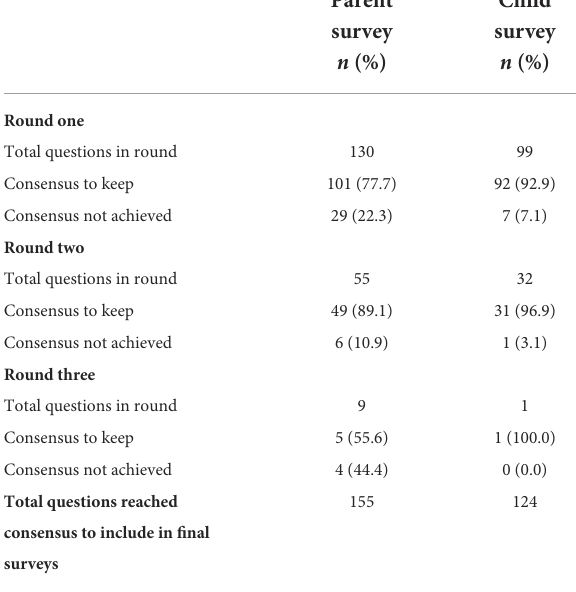
TABLE 4 Summary table of the Delphi method for each